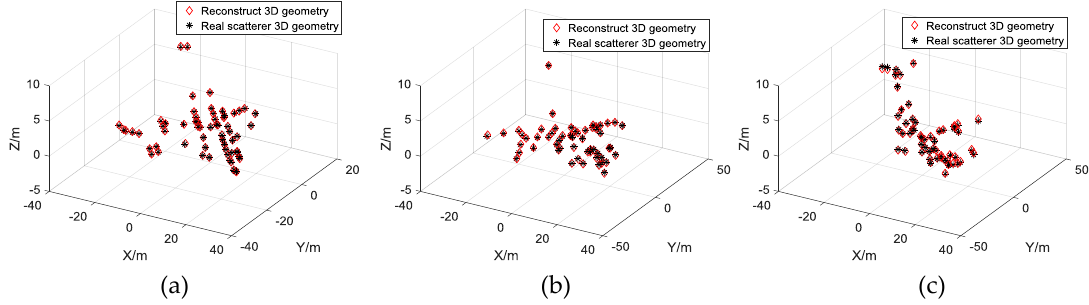
Figure 12. Variation of estimated attitudes of 3D reconstruction from three different perspectives. (a)~(c) The attitudes obtained by the proposed method from different perspectives.